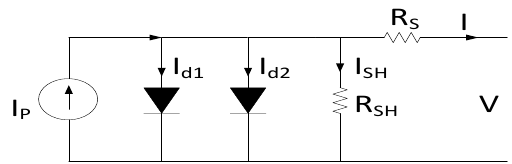
Figure 2. Equivalent circuit of double-diode model PV system.